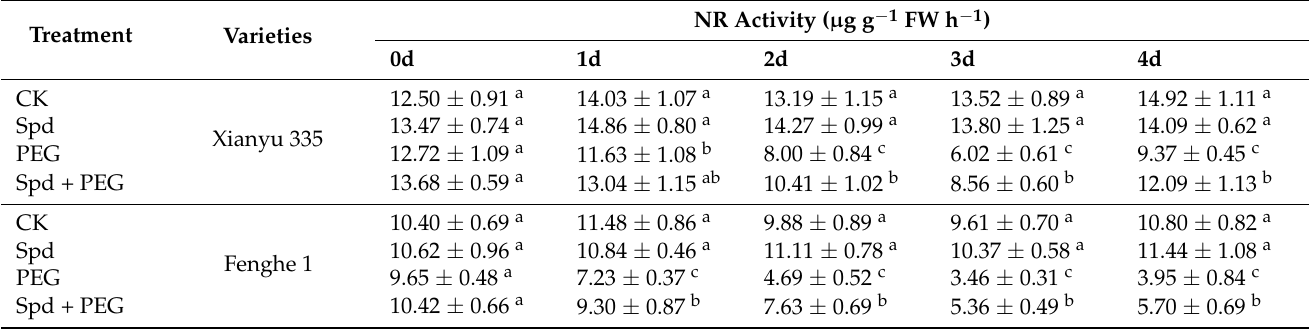
Table 3. Effects of exogenous spermidine on nitrate reductase (NR) activity in leaves of maize seedlings under drought